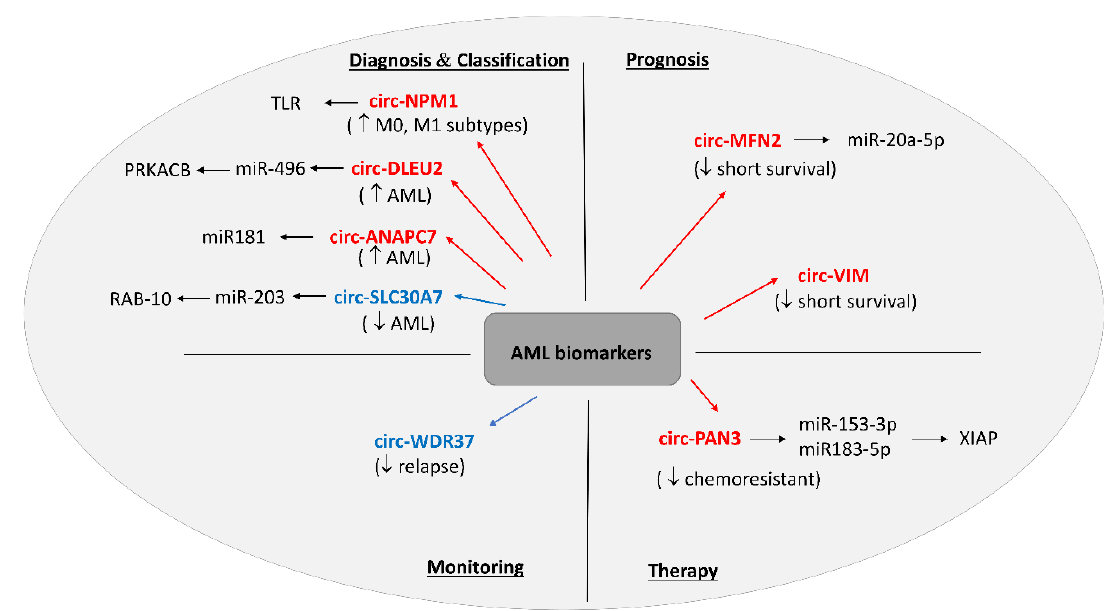
Figure 2. Summary of circRNAs suggested as potential acute myeloid leukemia (AML) biomarkers based on [78–84]. The deregulations of circRNAs are marked in red (upregulation) and blue (downregulation). The diagram also illustrates the circRNA–miRNA–mRNA axes.